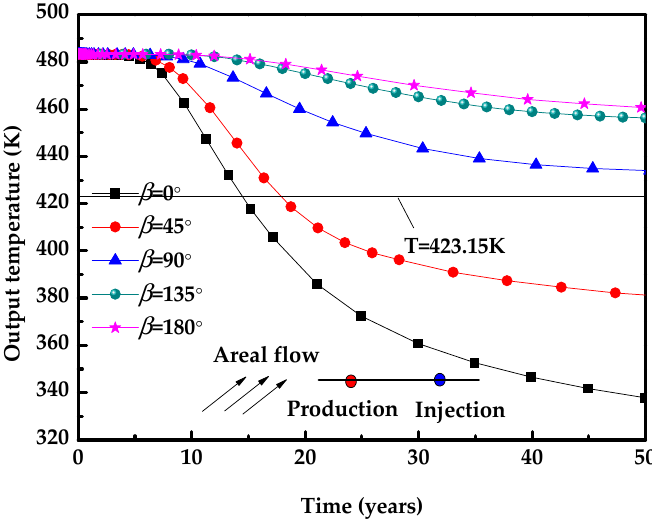
Figure 8. Temperature variation of reservoir after 50 years of each scheme.